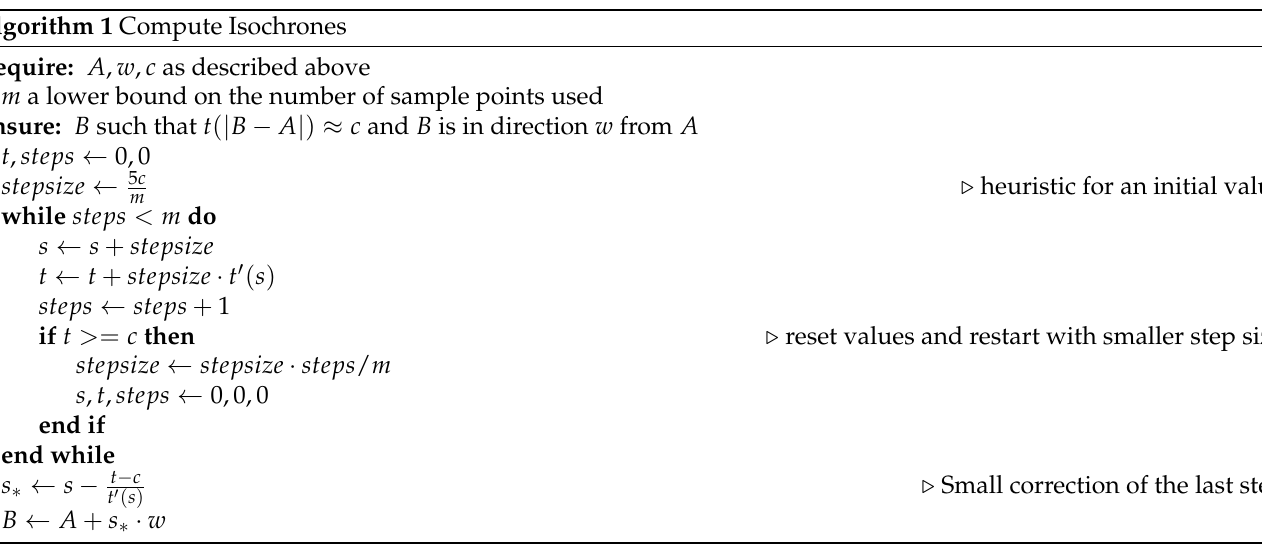
Algorithm 1 Compute